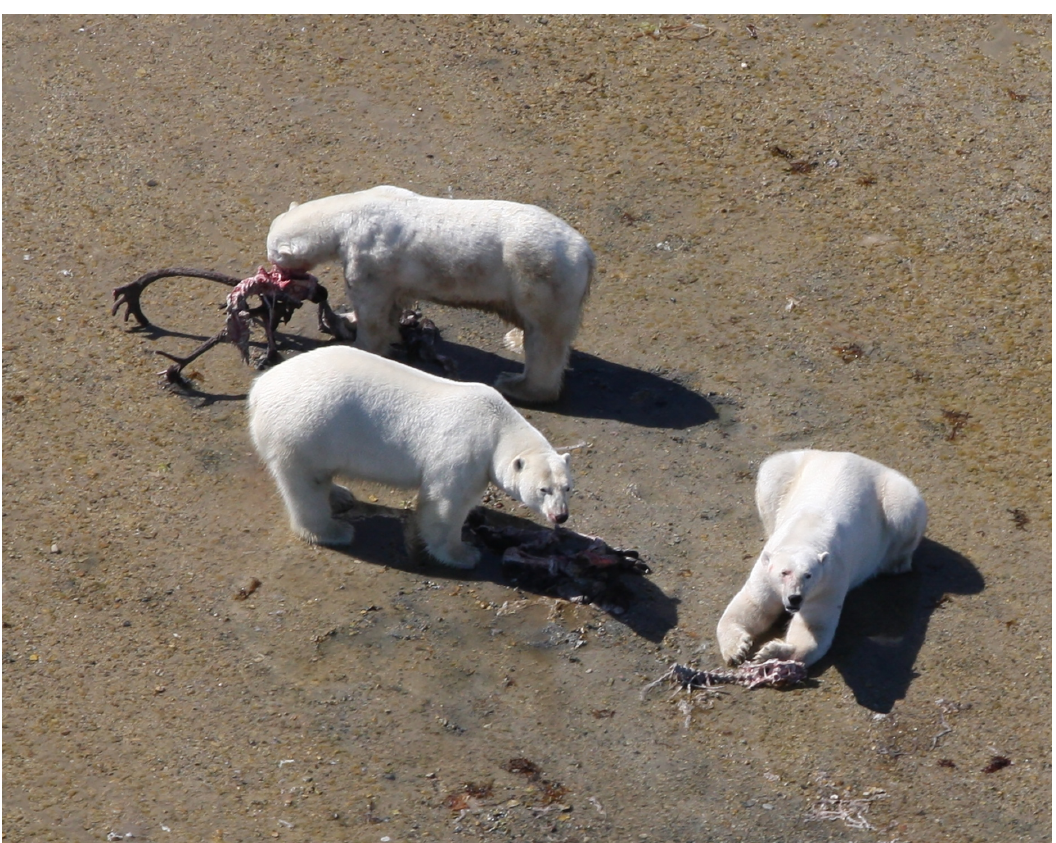
Fig 4. Three adult male polar bears feed on the remains of a bull caribou on Keyask Island (58.1695°N 92.8519°W) on the Cape Churchill Peninsula on 8 August, 2012. This type of communal foraging illustrates the importance of how consumption of incomplete carcasses (as carrion or from predation) can contribute to daily energy requirements. Here, the bear in the poorest physical condition (top) is most likely in need of the additional calories, however, those in better condition still partake in the meal. Photograph by R.F. Rockwell.